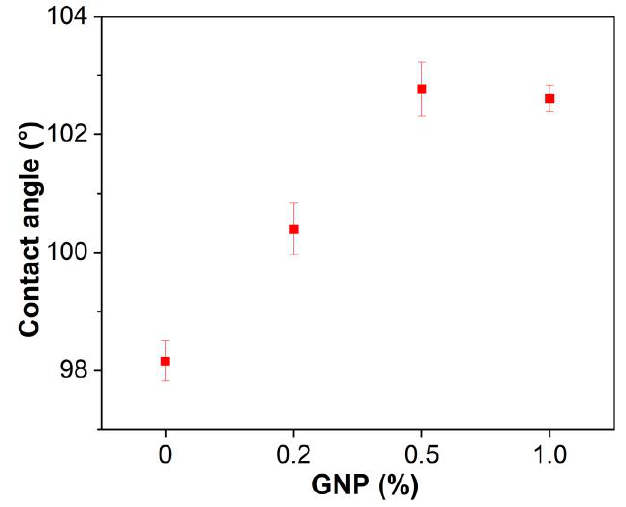
Figure 5. Water contact angles of GNP-reinforced EABCs.